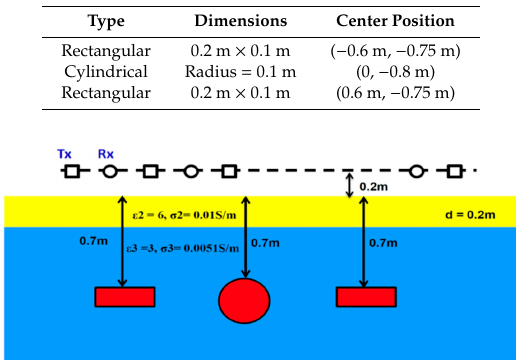
Figure 3. Scene comprising three metallic targets in a three-layered background environment [21].